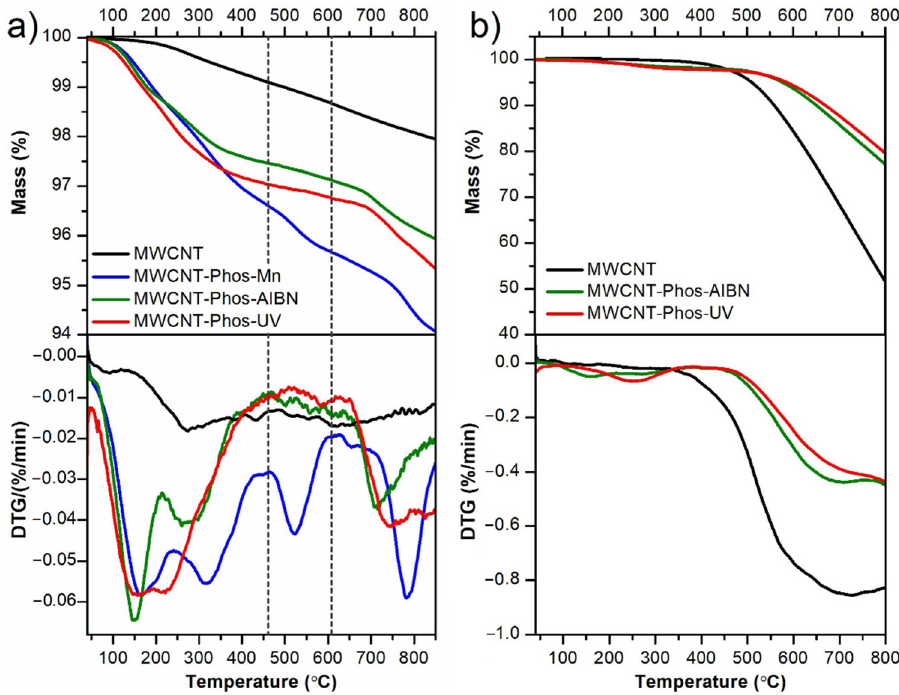
Figure 7. ( a ) TG (upper) and DTG (lower) curves recorded for pristine and functionalized MWCNTs in argon; ( b ) TG curves of MWCNT, MWCNT–Phos–AIBN and MWCNT–Phos–UV registered in synthetic air.